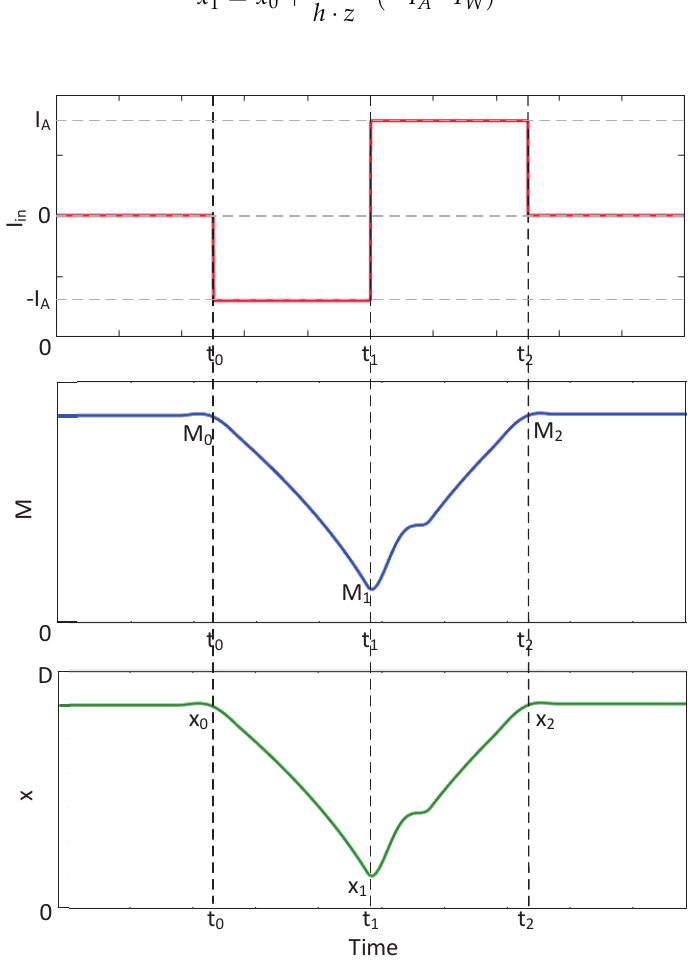
Figure 8. Symmetrical pulse current causes a change in the state of the memristor. From top to bottom are the input current I in , the memristance value M, and the curve of the state variable x with time. The amplitude of the second half current is I A , and the width is T W , and continue to switch the memristor state to x 2 as